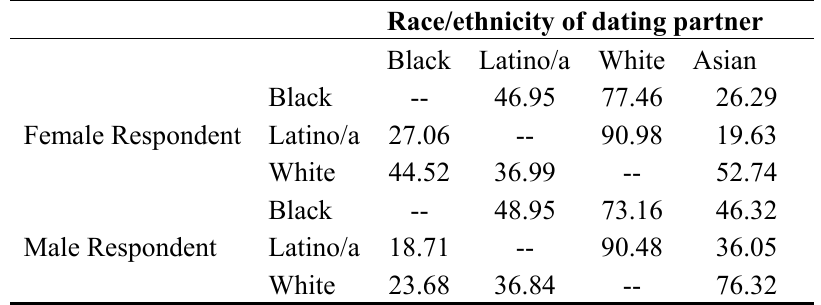
Table 2. Percent of intercultural daters that dated a member of given racial/ethnic